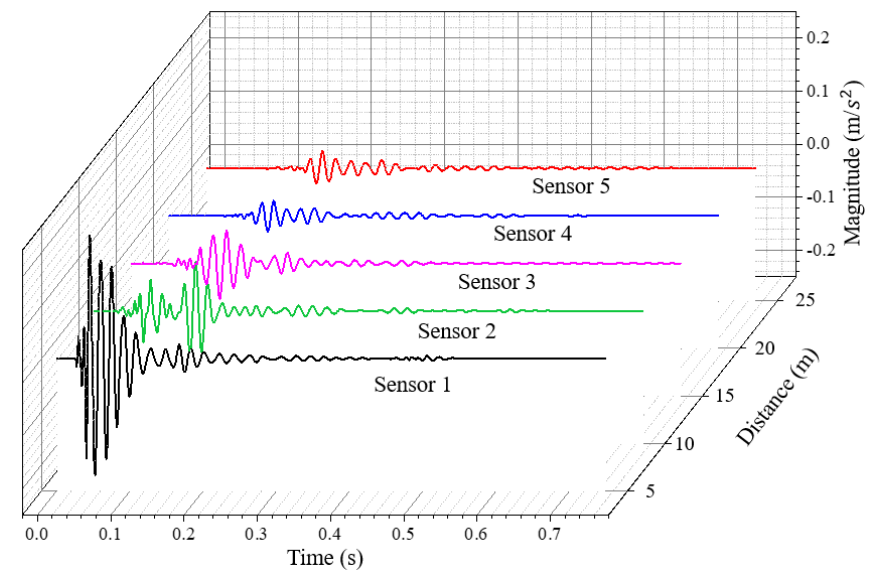
Figure 7. Recovered data of the five satellite-based sensing nodes.